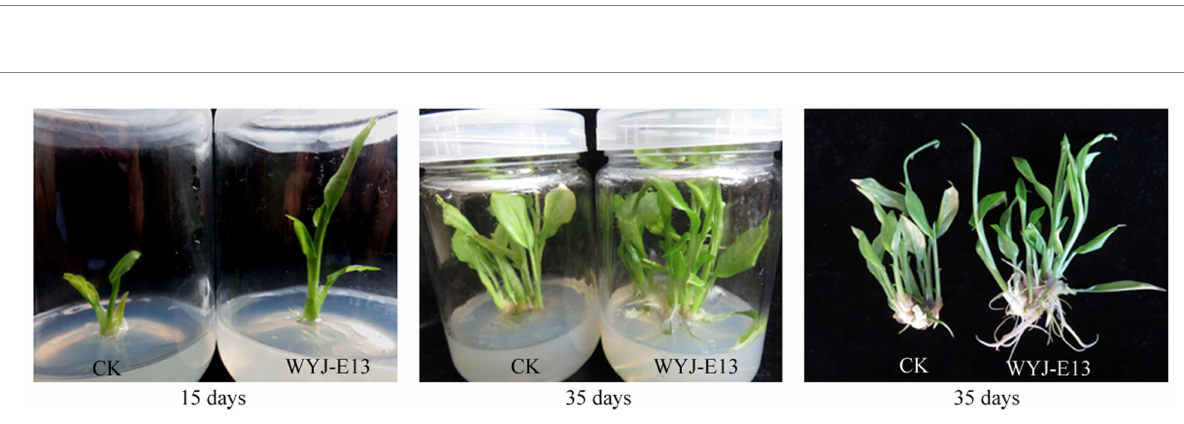
(Figure 4A). The goodness-of-fit (R2) and predictability (Q2) of